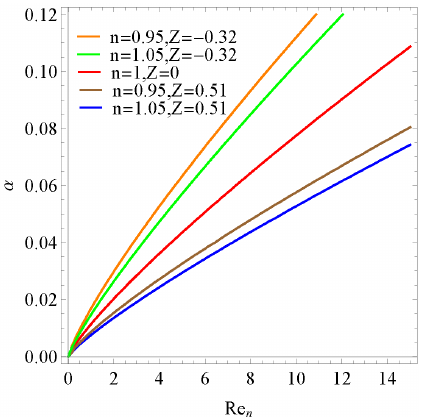
Figure 2. Neutral linear stability curves of the film flow for various n and Z